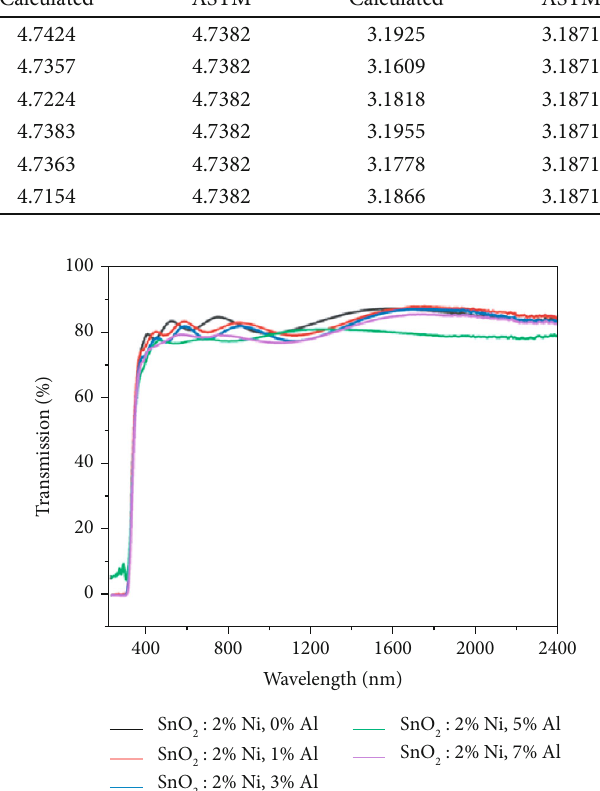
Table 1: Texture coe ffi cient and lattice parameters of the Al-Ni-codoped SnO Samples